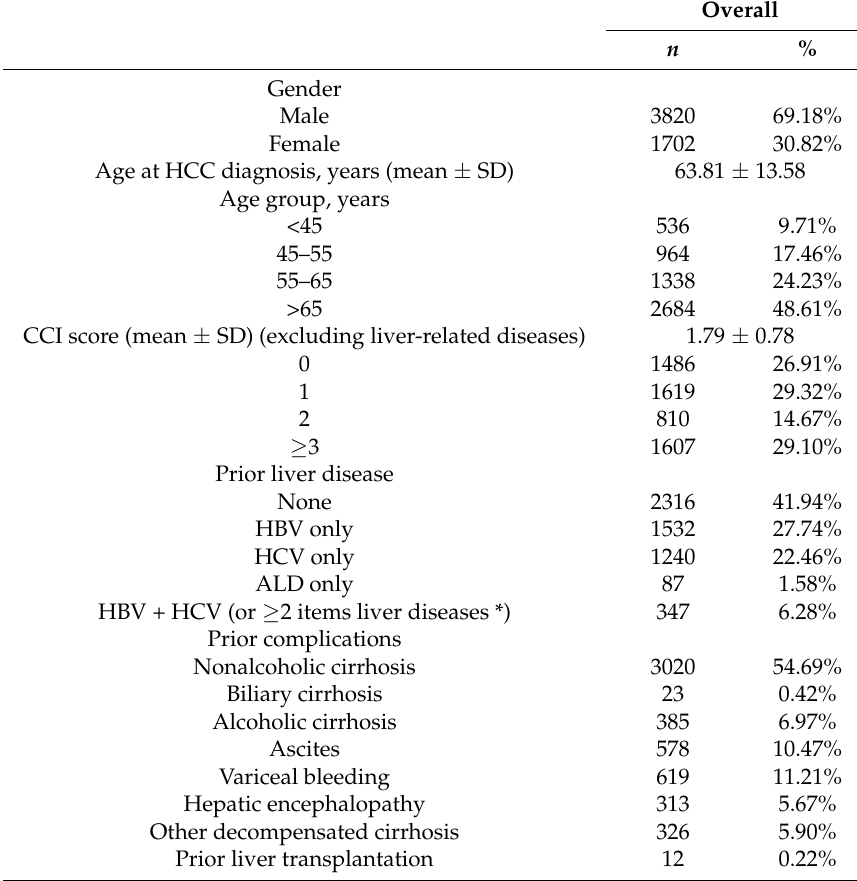
Table 1. Baseline characteristics of HCC